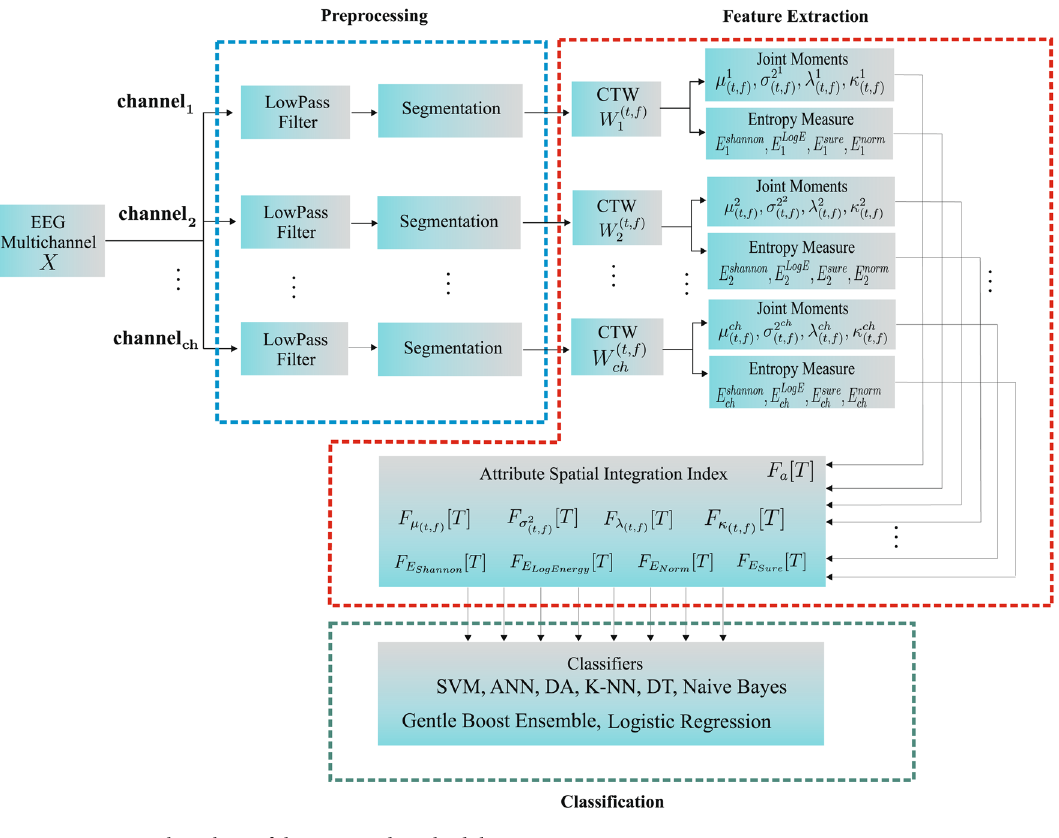
Figure 1. Flow chart of the proposed